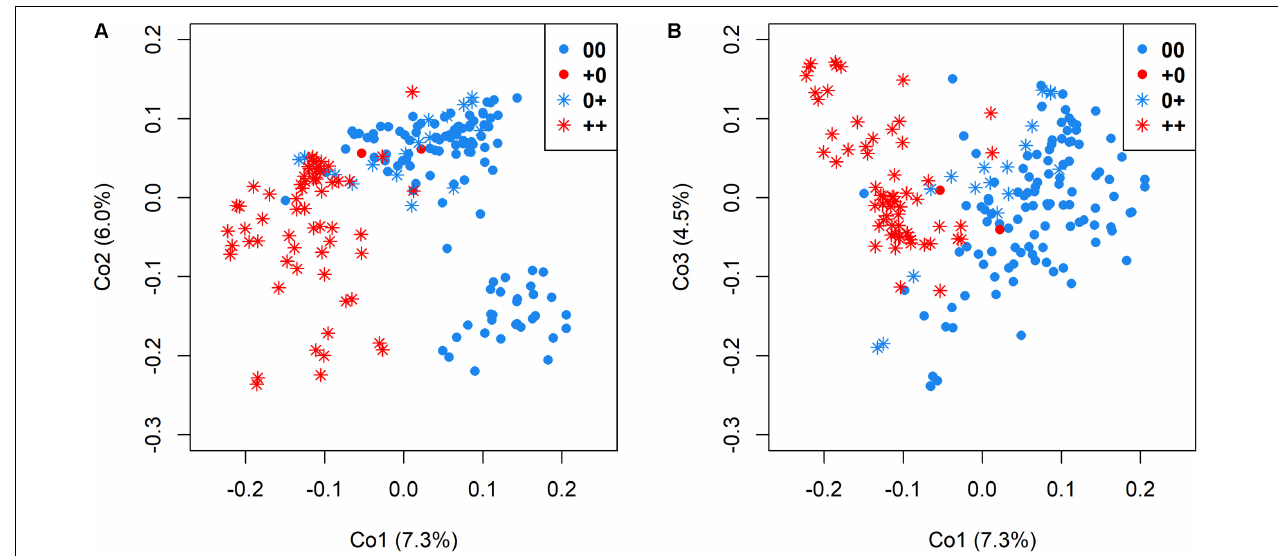
FIGURE 4 | Genetic relatedness of 215 genetically diverse winter-rapeseed lines shown in a principal coordinate analysis regarding the first and second coordinate (A) and the first and third coordinate (B) . Different seed qualities were represented by different colors and symbols.